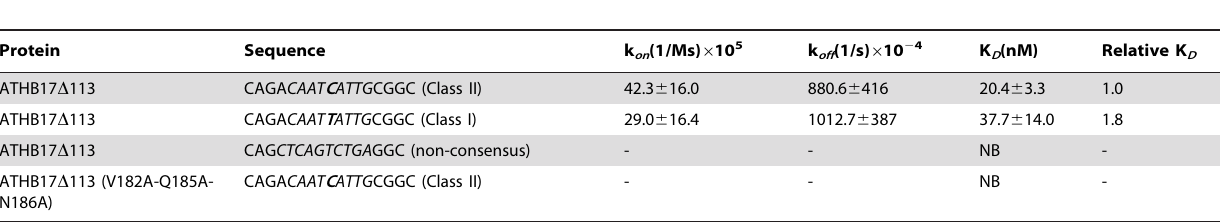
Table 1. ATHB17 D 113 can bind both Class II and Class I DNA targets and ATHB17 D 113 containing V182A-Q185A-N186A mutation cannot bind Class II DNA target in in vitro assay (measured by Surface Plasmon Resonance (SPR).